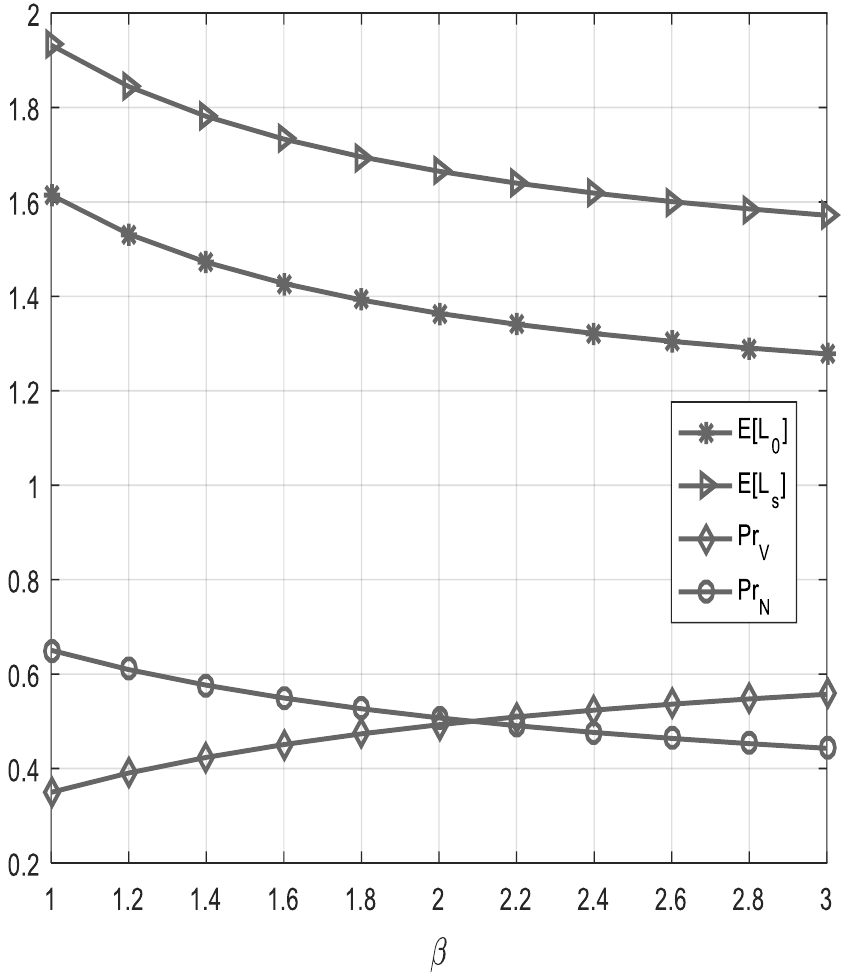
Figure 4. Effect of variation in retrial rate (β) on system performance